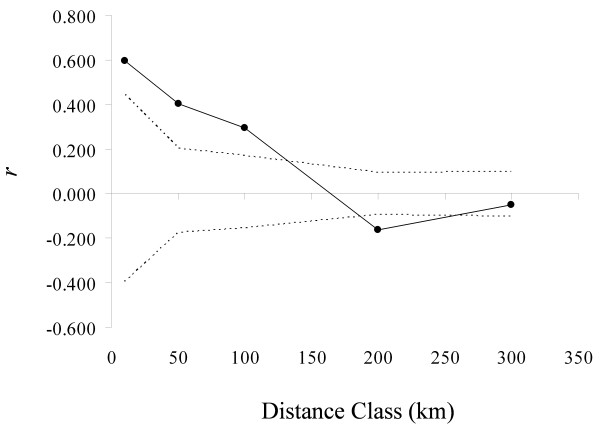
Pattern of isolation by distance. Pattern of isolation by distance in the wild populations. Correlogram plot of the genetic autocorrelation coefficient as a function of the geographical distance classes; dotted lines define the 95%-confidence interval based on 999 permutations.